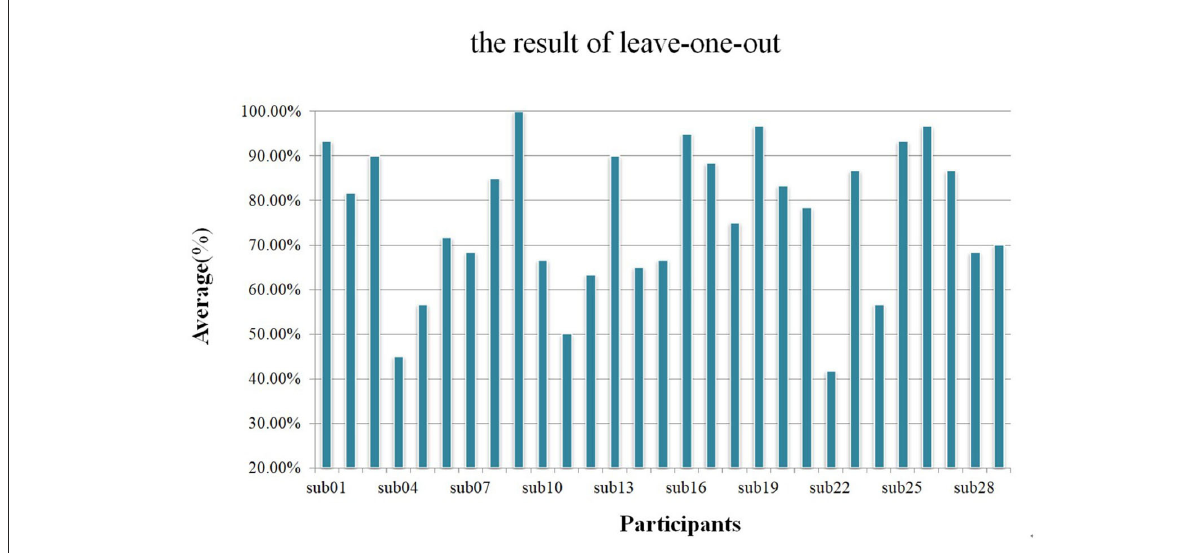
FIGURE9 Using a leave-one-out analysis scheme, the average accuracy of each participant with the voting